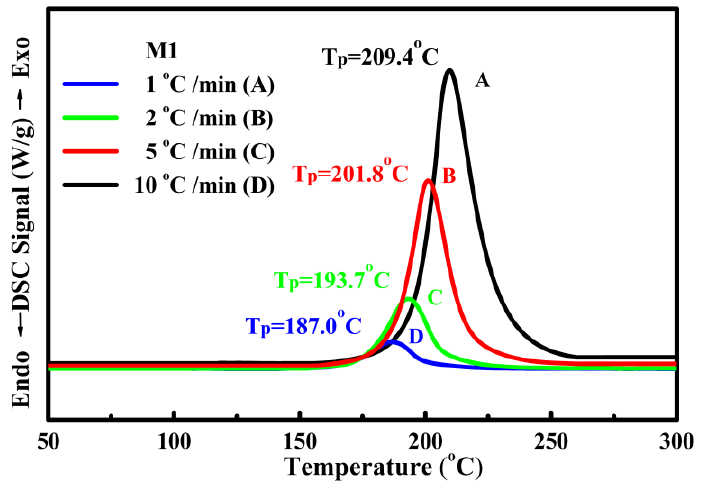
Figure 4. DSC curves of reference sample M1 at different heating rates of 1, 2, 5 and 10 °C min −1 .